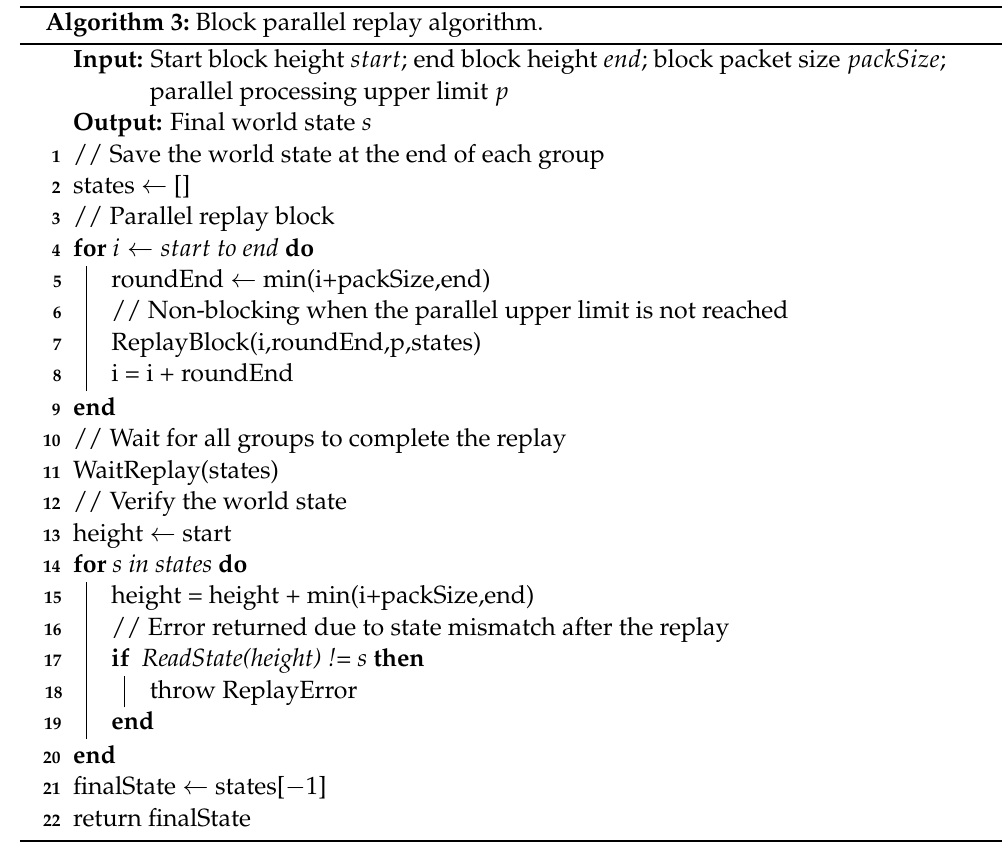
Algorithm 3: Block parallel replay